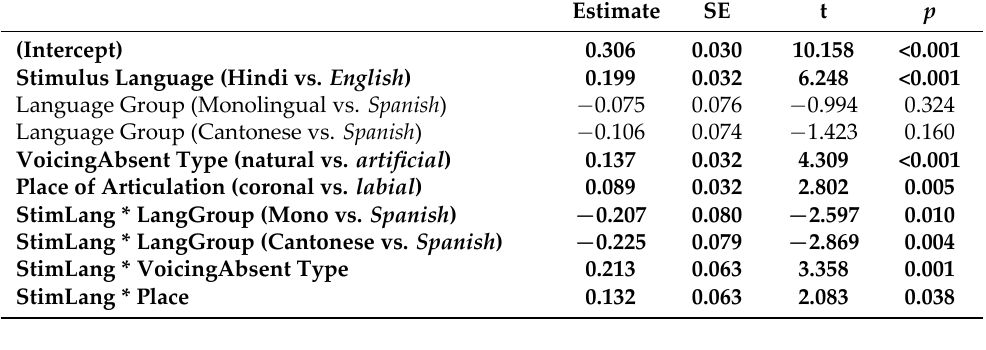
Table 5. Statistical results for the imitation task. Effects in bold are significant ( p < 0.05).